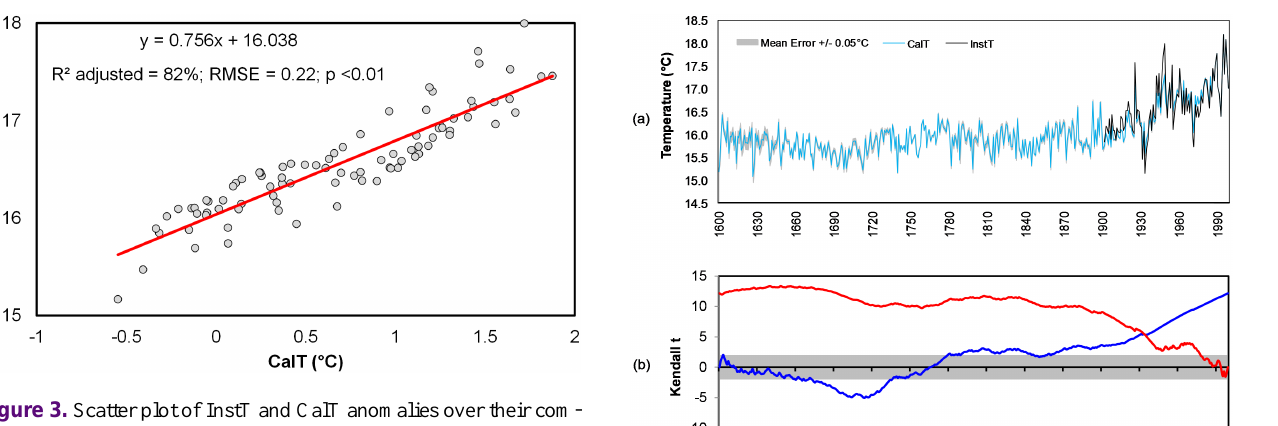
Figure 3. Scatter plot of InstT and CalT anomalies over their com- mon period (1901–1989). The corresponding regression line, cali- bration equation and R-squared measure (determination coefficient) are also shown.